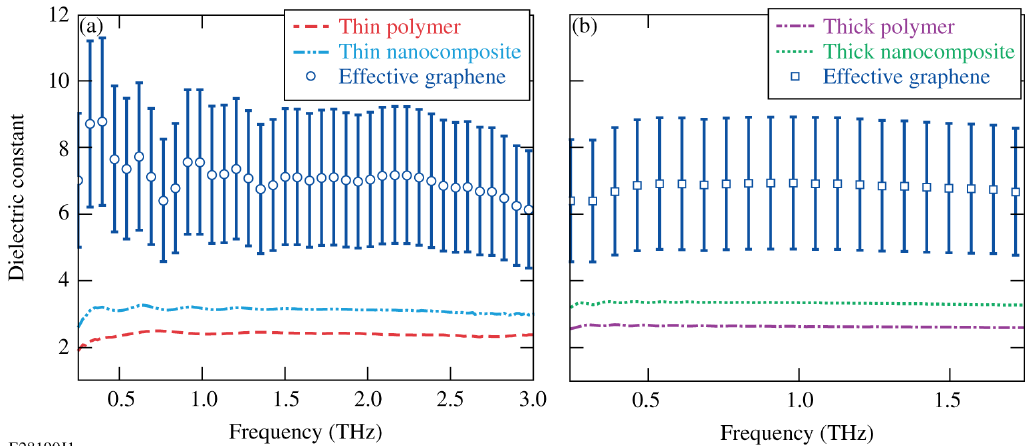
Figure 7. Real part of the complex dielectric function spectra (solid lines) for ( a ) thin and ( b ) thick polymer and 1-wt% graphene nanocomposite samples. Note: The thin samples consist of PET-DLA 4060 copolymer, while the thick one was PET-DLA 6040. The open circle and open square symbols present the effective graphene flake dielectric function based on the Clausius–Mossotti relation. The error bars are ~30%.